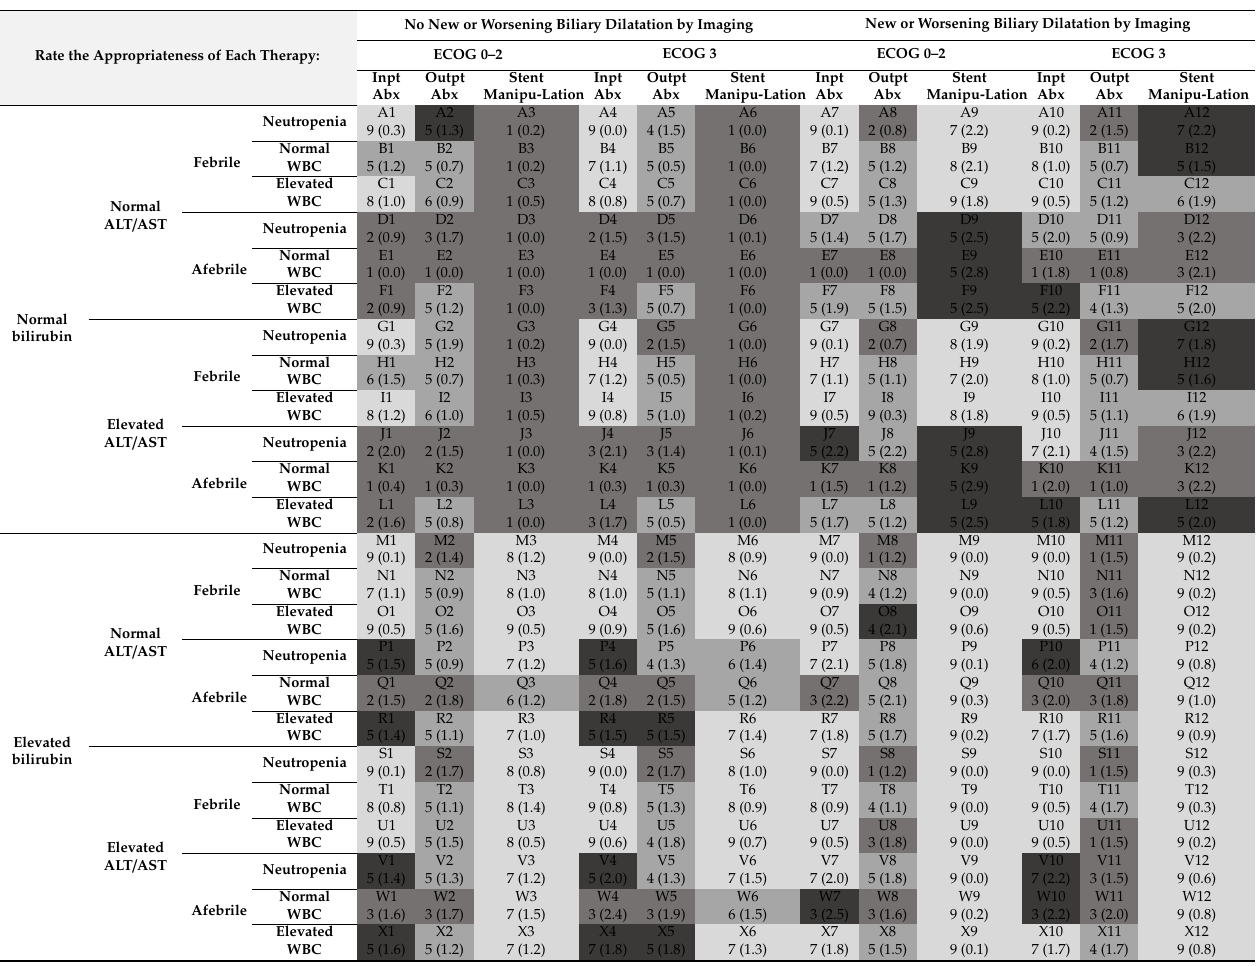
Table 2. Results according to patient scenario. In every cell below, indicate the appropriateness of therapy on a scale 1 to